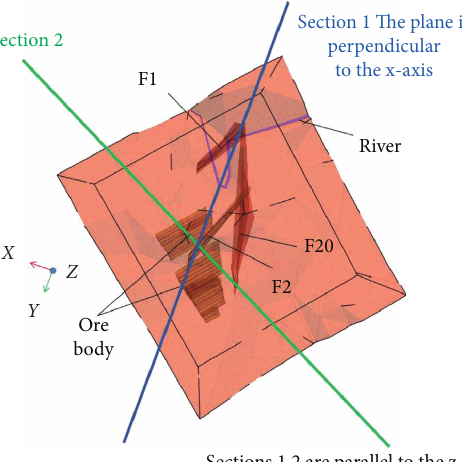
Sections 1,2 are parallel to the Figure 10: The positions of sections 1 and